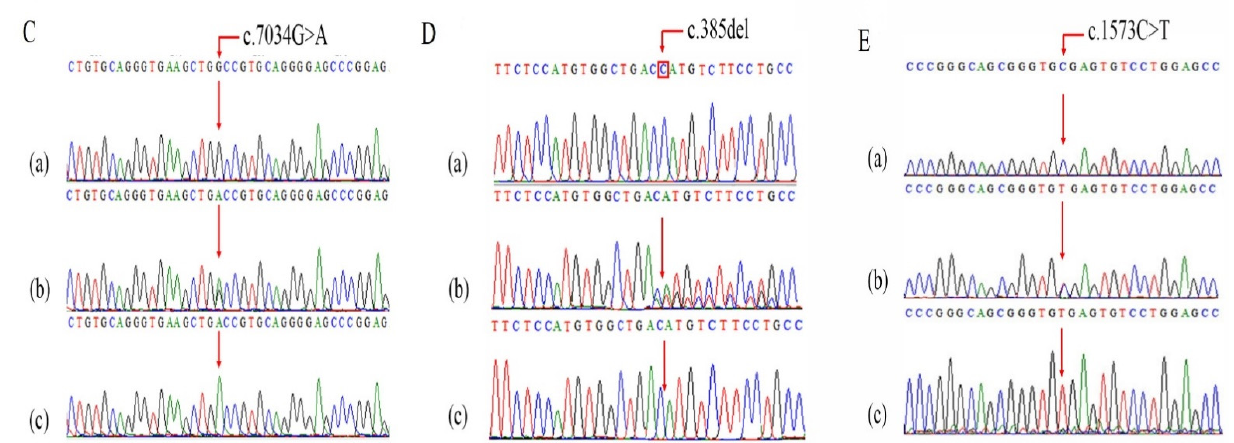
Figure 3. ( A ) Hypothetical structure of human chromosome 3 encoding COL7A1 gene on chromosome q21, shown by red box. ( B ) Hypothetical presentation of COL7A1 gene, consisting of 118 exons. ( C ) Sequencing analysis of exon 91 of COL7A1 gene in family A, showing a novel missense variant (c.7034G>A, p.Gly2345Asp) in the affected sibling (V-2) born to a consanguineous union: ( Ca ) affected (V-2), ( Cb ) obligate carriers or parent(IV-1), ( Cc ) wild type or unrelated healthy control. ( D ) Sequencing analysis of exon 3 of COL7A1 gene in family B, showing a frameshift mutation c.385del (p.His129MetfsTer18) in homozygous form in the affected sibling (V-1) born to a consanguineous union: ( Da ) wild type or unrelated healthy control, ( Db ) obligate carriers or parent(IV-1), ( Dc ) affected (V-1). ( E ) Sequencing analysis of exon 12 of COL7A1 gene in family C, showing a nonsense variation (c.1573 C>T; p. Arg525Ter) in the affected sibling (V-2) born to a consanguineous union: ( Ea ) affected (V-2), ( Eb ) obligate carriers or parent (IV-1), ( Ec ) wild type or unrelated healthy control. The solid red lines represent positions of the mutations.